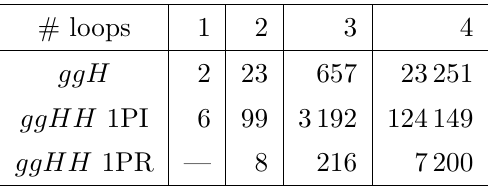
Table 2 . Number of diagrams contributing to the Higgs-gluon amplitudes up to four loops.